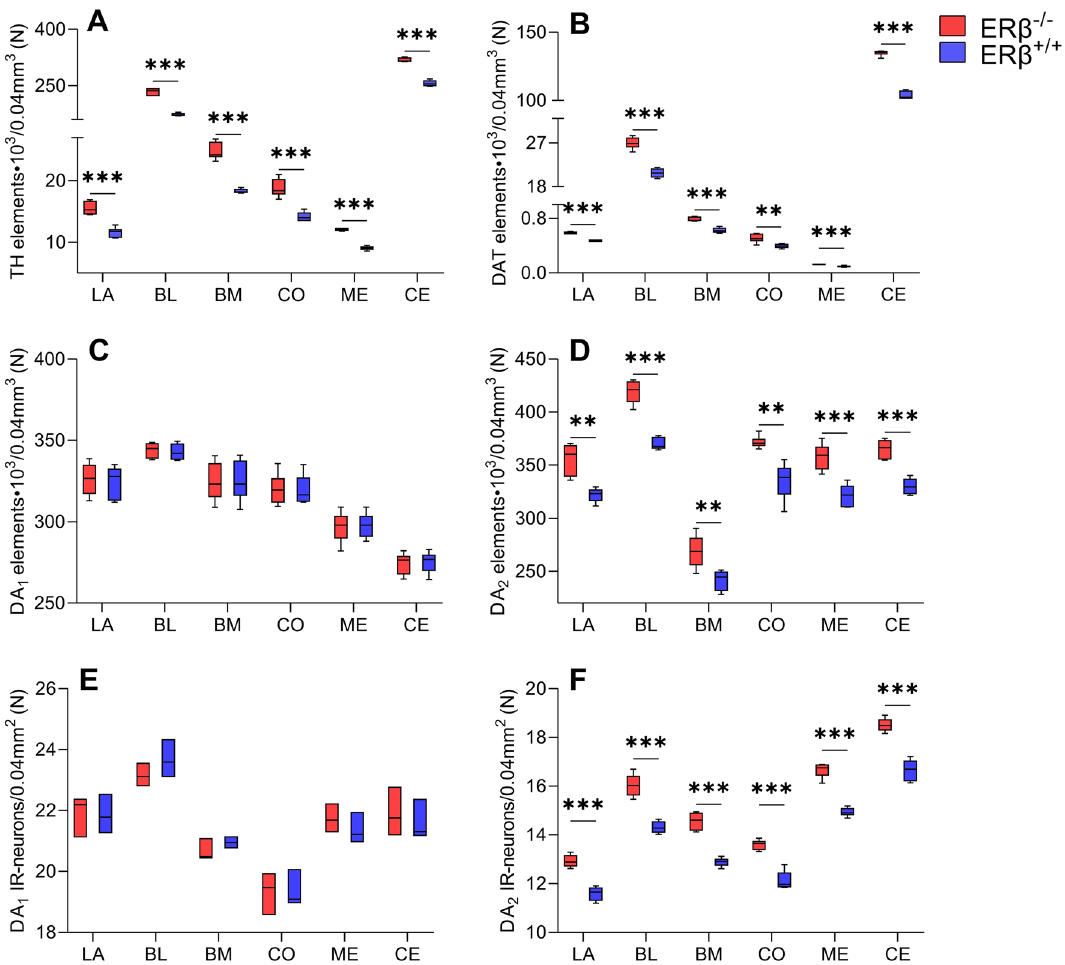
Figure 1. The densitometry of dopaminergic markers such as tyrosine hydroxylase (TH), dopamine transporter (DAT), dopamine D 1 -like receptor (DA 1 ) and dopamine D 2 -like receptor (DA 2 ) in the amygdala of ERβ knock- out (ERβ −/− ) and wild-type (ERβ +/+ ) mice, n = 6 per group. Note that the volume density of TH ( A ), DAT ( B ) is significantly elevated in ERβ −/− mice when compared to ERβ +/+ mice whereas values for DA 1 ( C ) do not differ in both mice lines but for DA 2 ( D ) is significantly elevated in ERβ −/− mice. Additionally, note that the automated cells counting for DA 1 ( E ) are not affected but DA 2 ( F ) is significantly increased due to ERβ deficiency. Data are expressed as a box-and-whiskers plots, with the "box" depicting the median and the 25th and 75th quartiles, and "whiskers" showing 5th and 95th percentile. ** ( p ≤ 0.01) and *** ( p ≤ 0.001) indicates statistically significant differences between the studied groups of mice (ERβ −/− and ERβ +/+ mice) analysed by Student’s